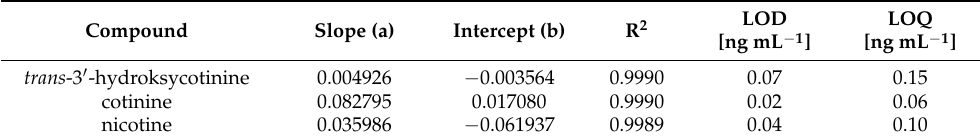
Table 4. The statistical parameters of the calibration curves (y = ax + b).